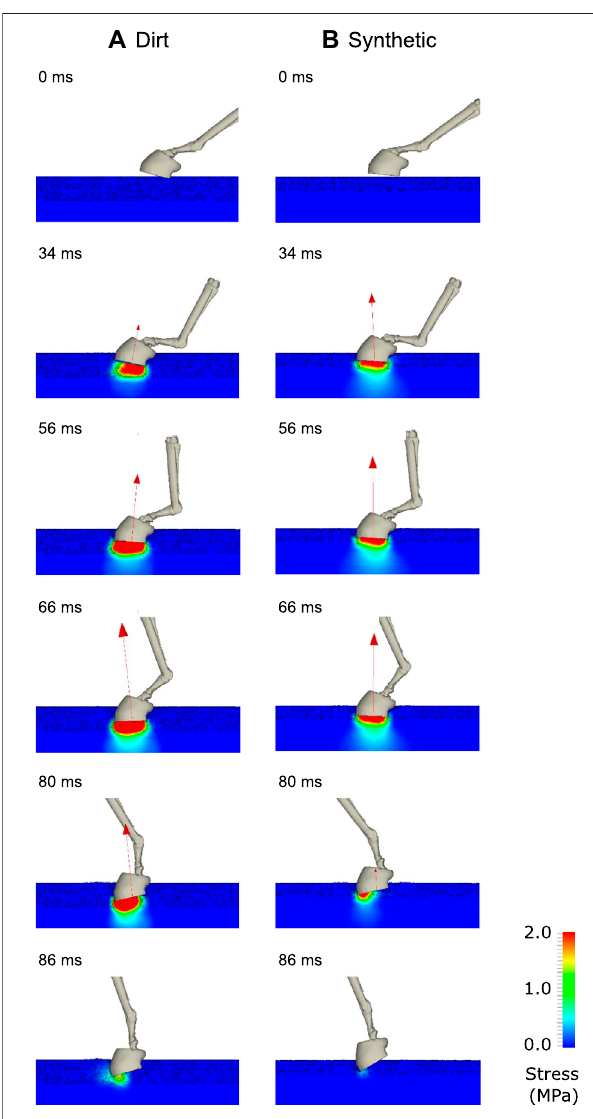
FIGURE 12 | Visualisation of the gait simulations using the coupled B- SPH model for (A) the dirt track and (B) the synthetic track. The bones of the distal limb and the outside surface of the hoof are shown in each instant. The ground reaction force is shown as a red vector. The track surface is coloured by von Mises stress.